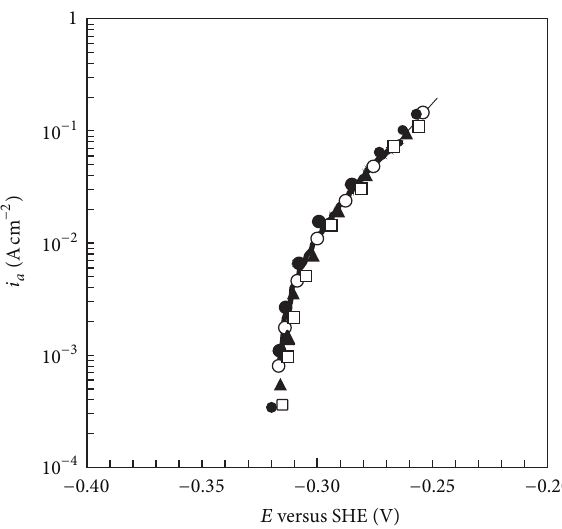
Figure 4: Anodic polarization curves of the specimen no. 3 in a sulfuric acid solution at pH = 2.0, with a variety of potential sweep rates: ( I ) 0.1 Vs −1 , ( 󳵳 ) 0.05 Vs −1 , ( ◻ ) 0.01Vs −1 , and ( ∙ ) 0.005 Vs −1 .